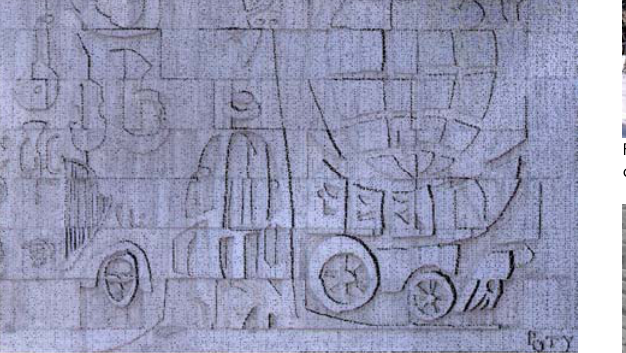
Figure 8. ‘Image Texture Map’ Point Cloud